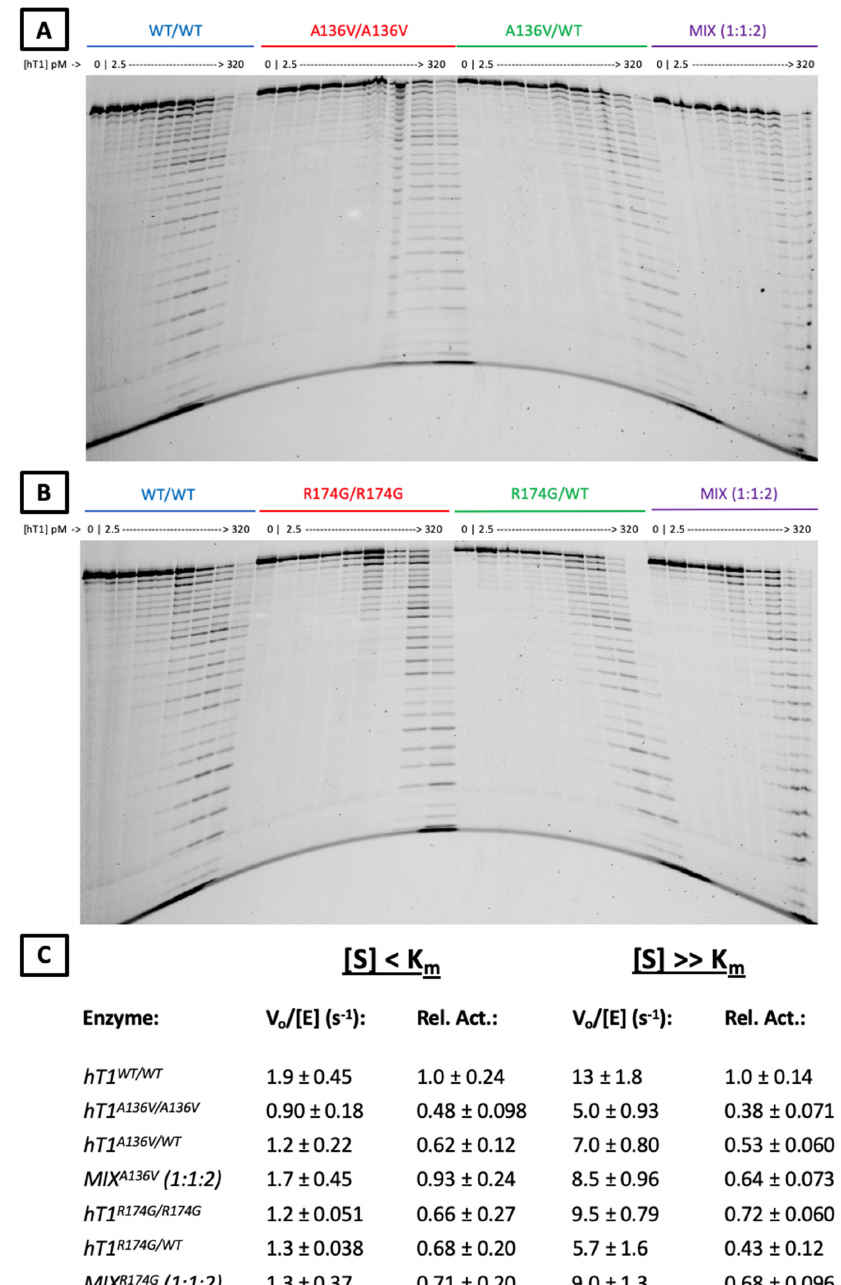
Figure 5. ssDNA exonuclease activities of p.A136V and p.R174G variants. ( A , B )